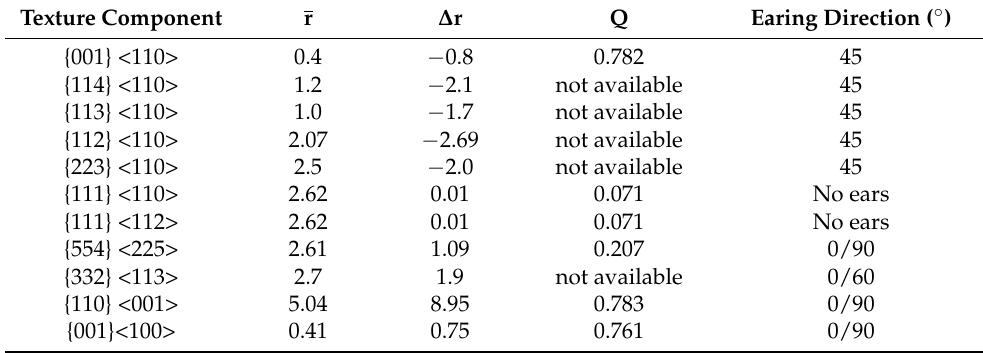
Table 6. The r, ∆ r, Q and earing direction for main texture components. Texture